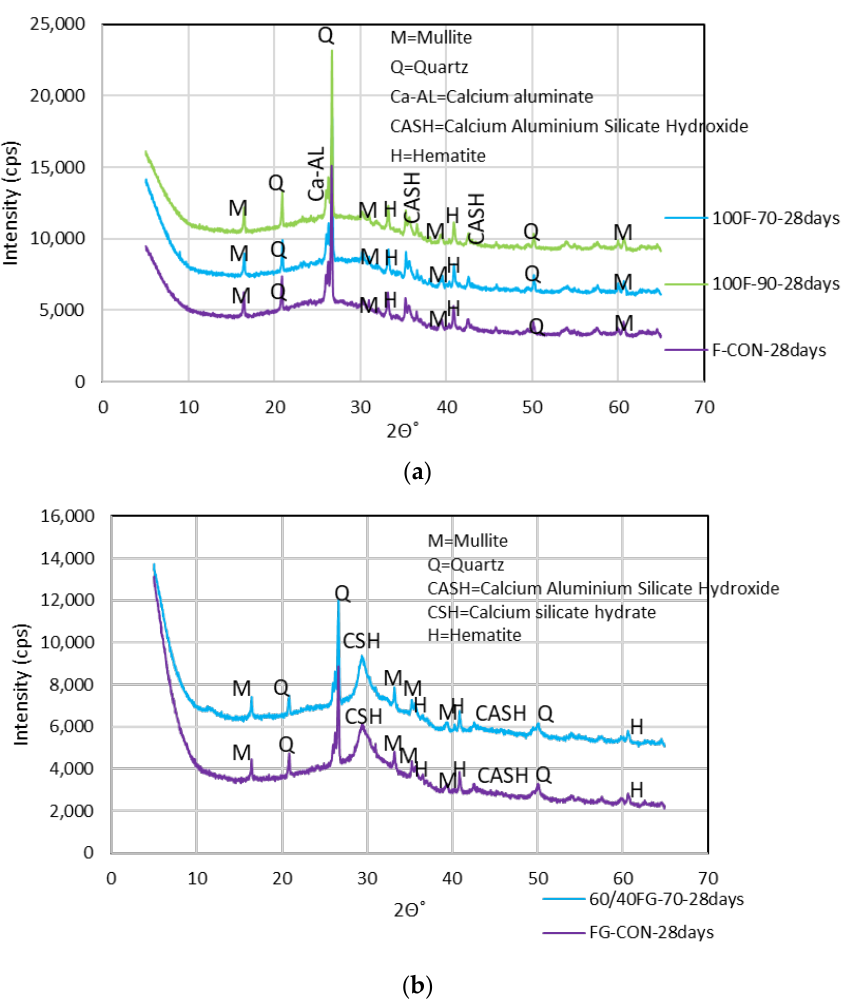
Figure 3. ( a ) XRD of neat fly ash activated with WG-based and commercially available activators at 28 days . ( b ) XRD of 60/40 fly ash/slag activated with WG-based and commercially available activators at 28 days .